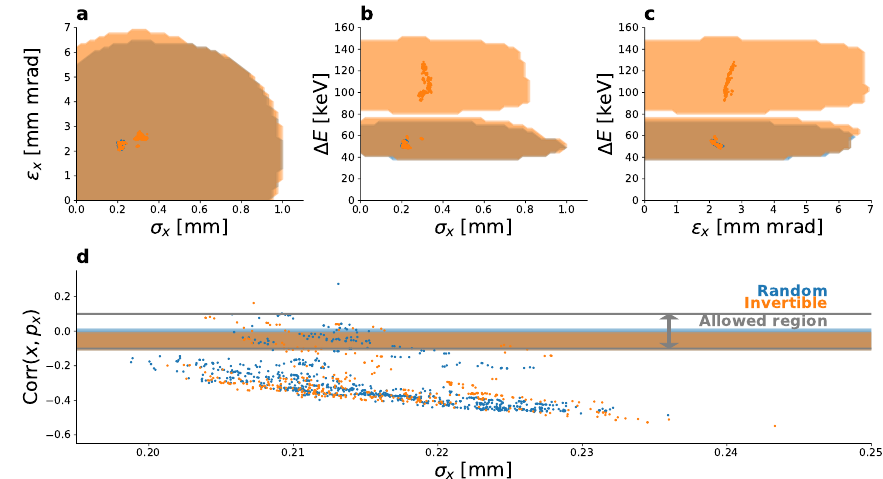
Figure 5. OPAL validation of the non-dominated feasible machine settings among all 1000 generations (dots) as calculated using the forward surrogate model. The colour blue marks optimisation with random initialisation, whereas orange indicates that the invertible model provided the initialisation. The dots are the results of an OPAL run, and the shaded areas mark values predicted by the forward model plus/minus uncertainty at 90%